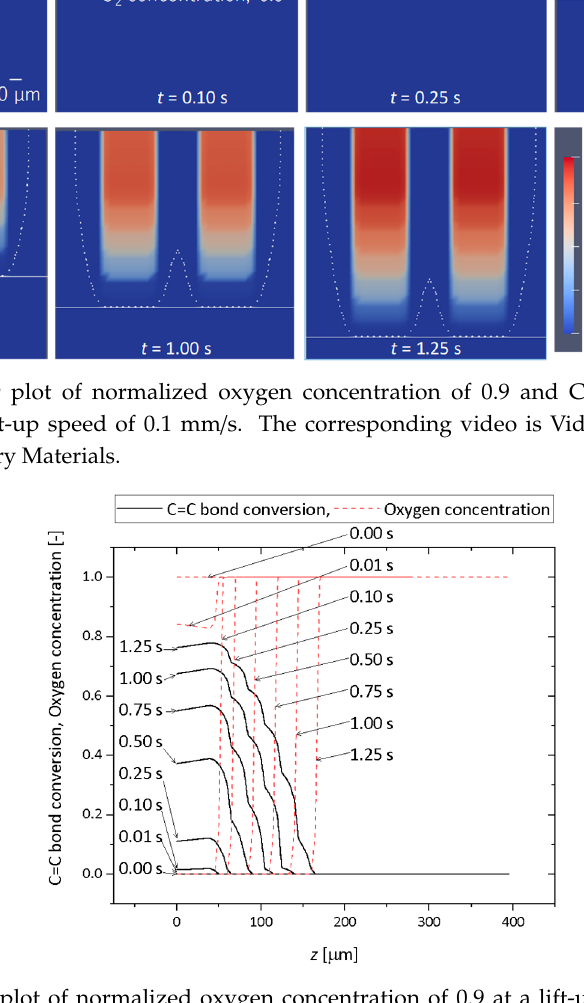
Figure 4. Superposition of the contour plot of normalized oxygen concentration of 0.9 and C=C bond conversion as well as UV light position at a lift-up speed of 0.1 mm/s. The horizontal arrows on the left side are the position of UV light for each time point.